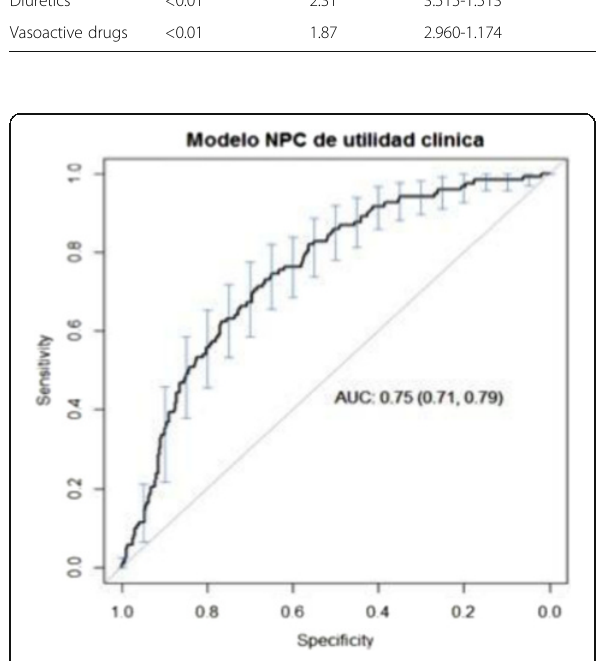
Fig. 126 (abstract A324). ROC curve of the